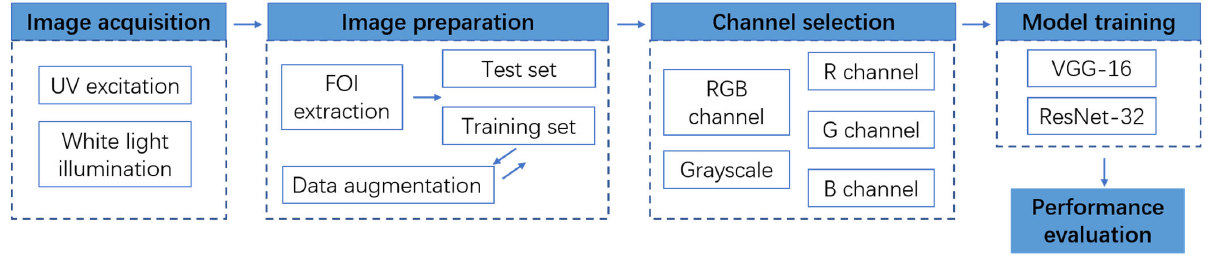
Figure 6. Flowchart of the proposed tea classification